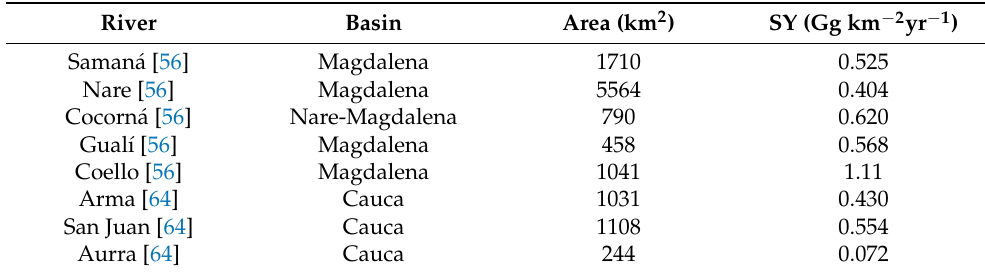
Table 3. Average sediment yield values estimated in tributaries catchments of Cauca and Mag- dalena rivers.